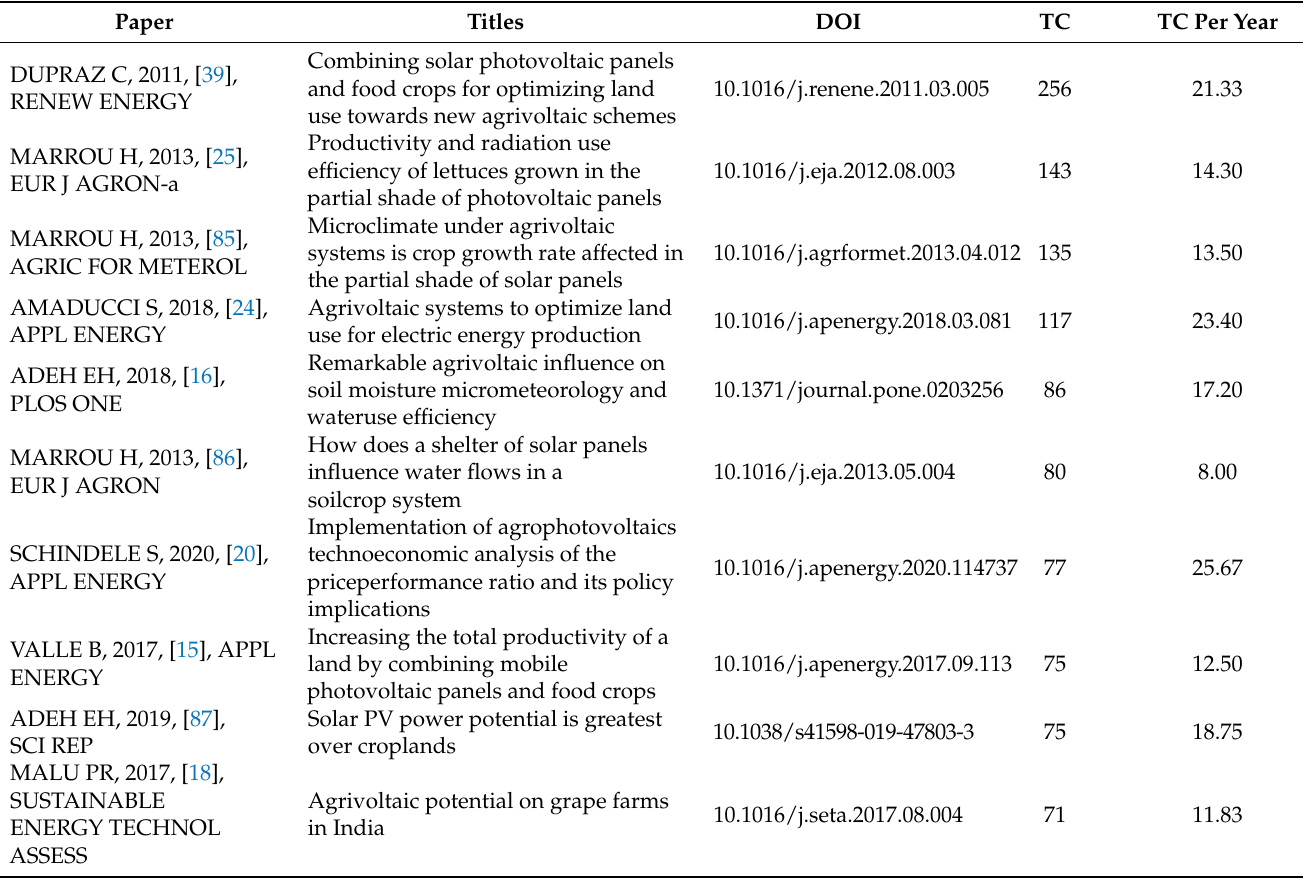
Table 4. Most cited